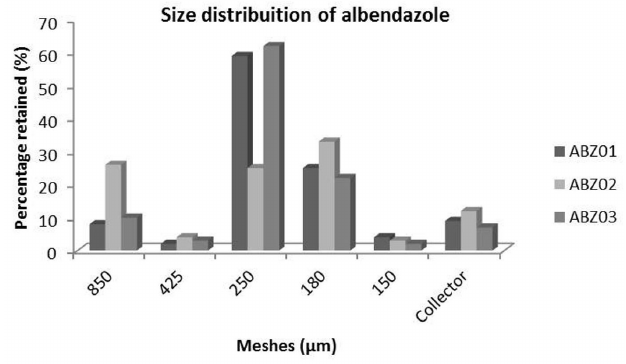
FIGURE 5 - Granulometric distributions of ABZ01, ABZ02, and